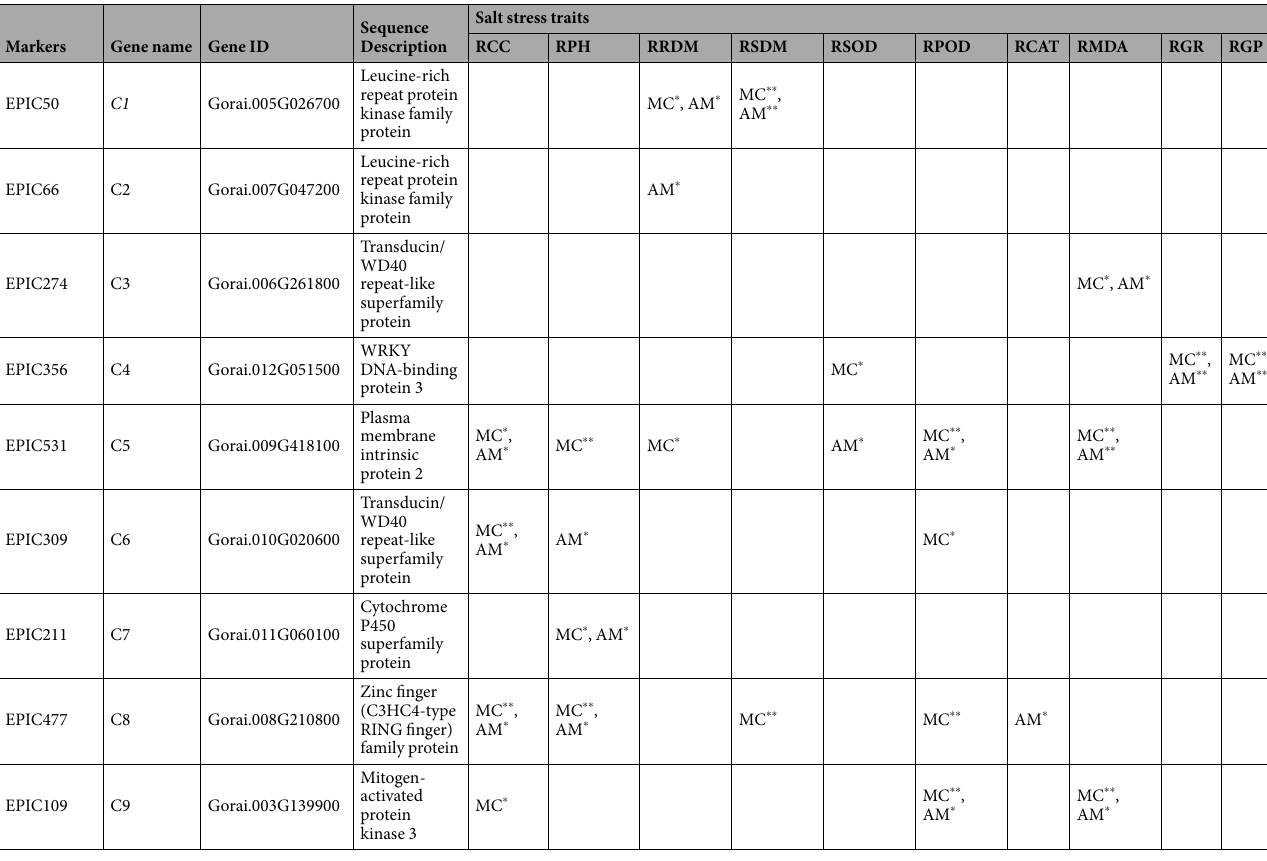
Table 4. Association information on ILP marker-traits related to salt stress. 1 MC and AM means marker- trait associations detected in multiple comparisons and association mapping analysis, respectively. 2 * and ** : significant difference P < 0.05 and P < 0.01, respectively. 3 Abbreviation for 10 traits related to salt tolerance is relative chlorophyll content (RCC), relative plant height (RPH), relative root dry matter (RRDM), relative shoot dry matter (RSDM), relative SOD activity (RSOD), relative POD activity (RPOD), relative CAT activity (RCAT) and relative MDA content (RMDA), relative germination rate (RGR), relative germination percentage (RGP),